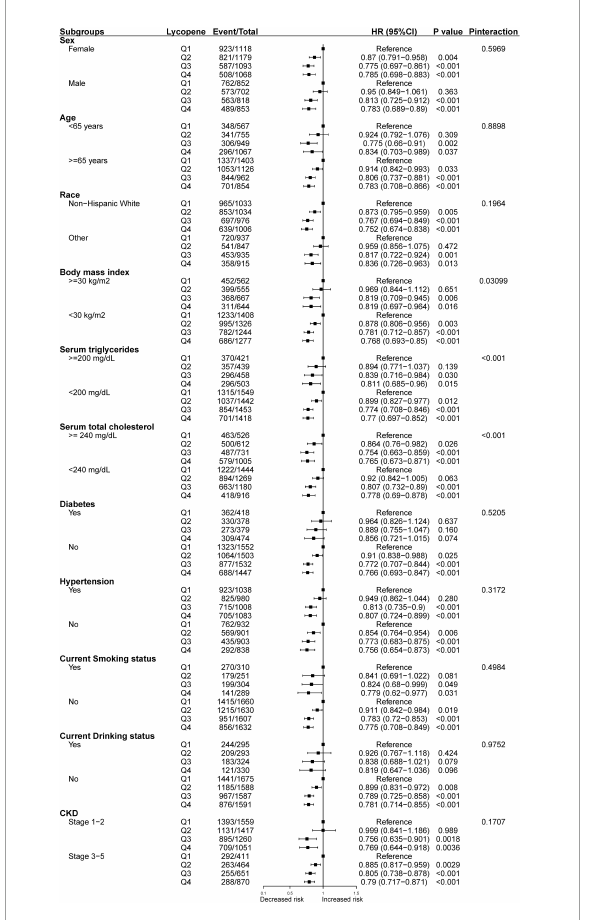
FIGURE3 Subgroup analyses of the association between serum lycopene concentrations and all-cause mortality.